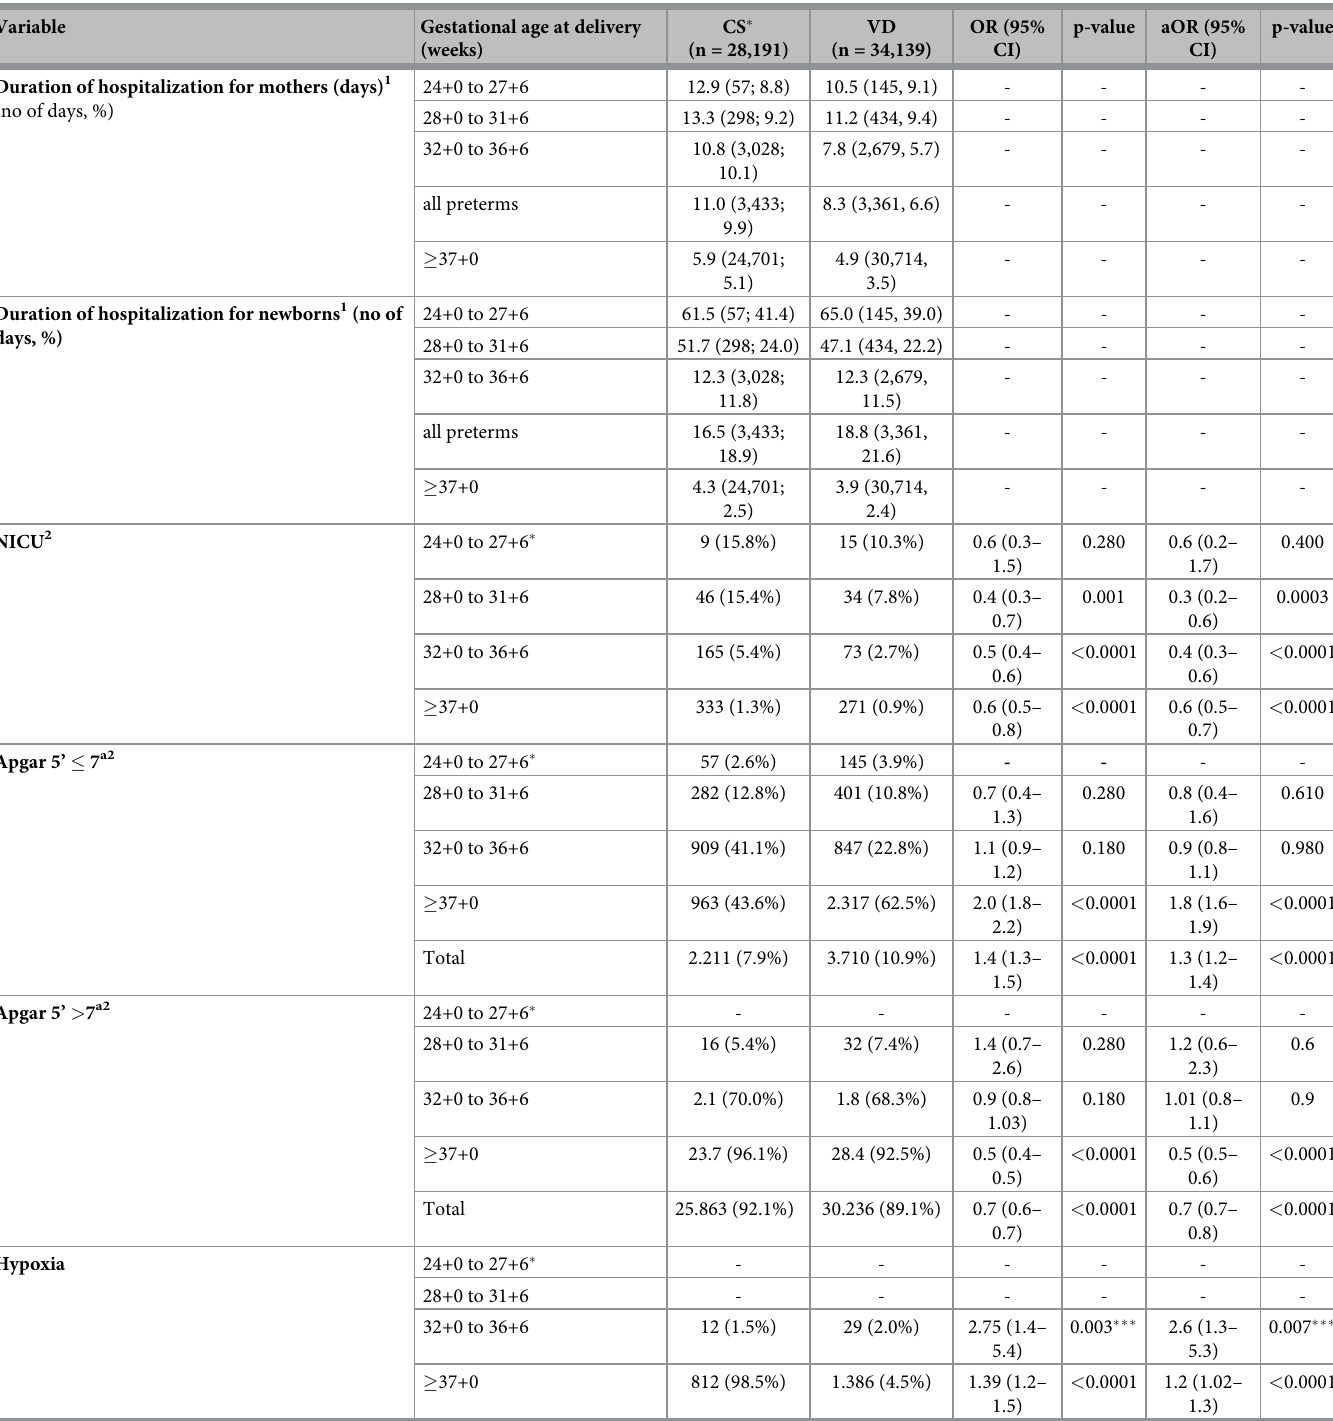
Table 2. Maternal and neonatal birth outcomes for preterm and term, caesarean section and spontaneous vaginal deliveries stratified by gestational age.